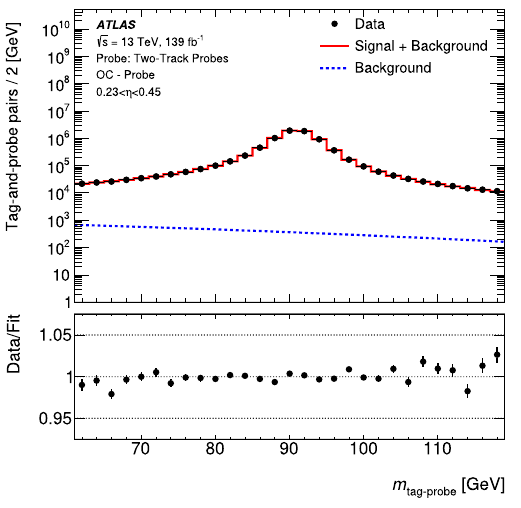
Fig. 6 Fit to the m tag − probe distribution for the selected probes (left), and the probes matched to the Medium selection (right), for two-track probes with 0 . 23 < η < 0 . 45 and opposite-charge (OC) tag-and-probe pairs. The blue line indicates the fitted non-prompt muon background